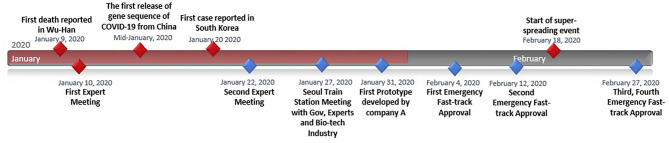
Timeline of COVID-19 test kit development (14–17).